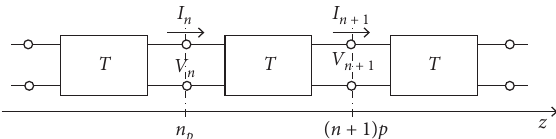
Figure 4: Equivalent network of a periodic line with minimal period p .